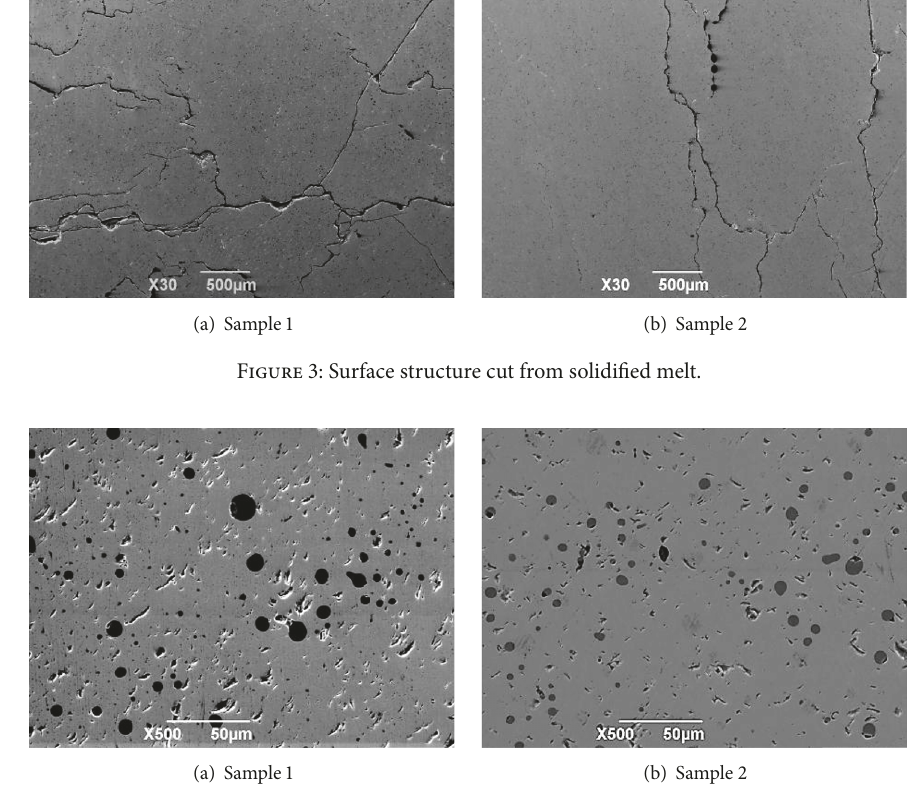
Figure 4: Metallic contaminations in sample microstructure on magnification of ×